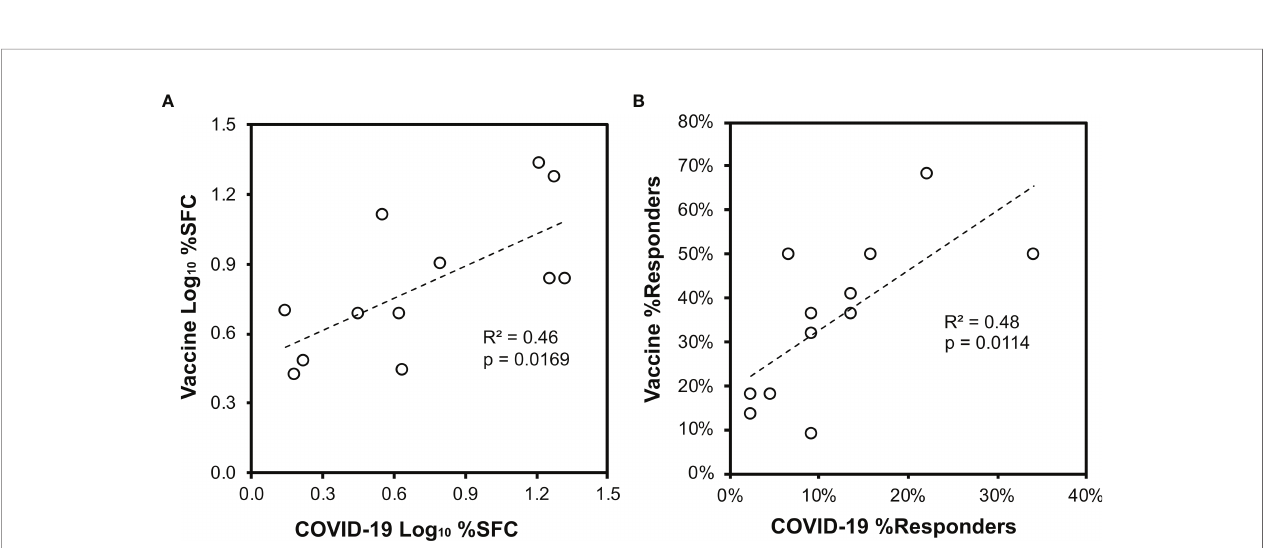
FIGURE 6 | Vaccination of persons without prior SARS-CoV-2 infection elicits CD8 + T cell targeting of spike similar to natural infection. Across the 44 persons with recent SARS-CoV-2 infection ( Figure 3 ) and 22 persons after vaccination without prior SARS-CoV-2 infection ( Figure 5 ), CD8 + T cell responses against spike de fi ned by ELISpot were compared. Pearson correlation p values are indicated. (A) The mean percentage contribution of each pool to the total spike response (log 10 transformed) is plotted between the two groups. (B) The percentage of persons responding against each pool is plotted between the two